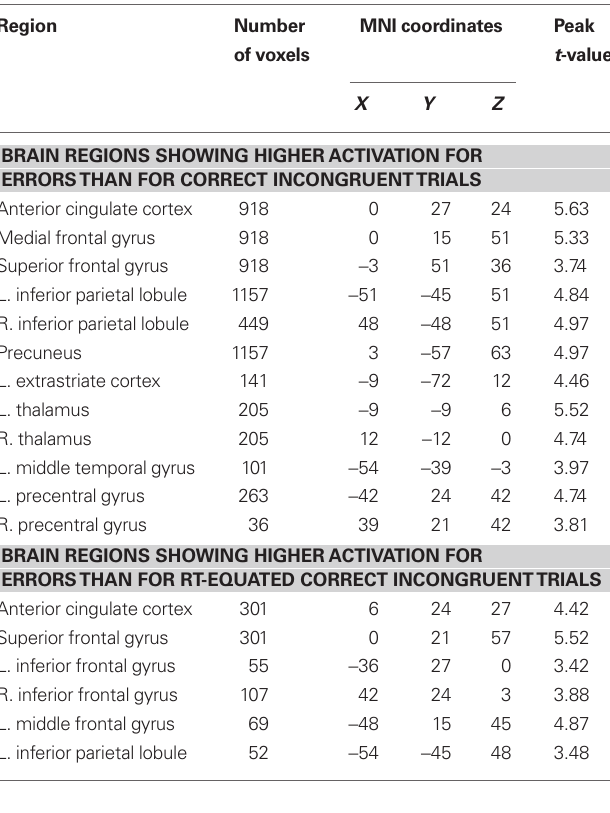
BRaIN RegIONs sHOwINg HIgHeR acTIvaTION FOR eRRORs THaN FOR cORRecT INcONgRueNT TRIaLs